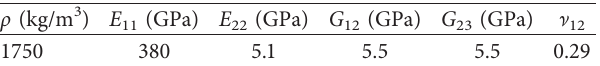
Table 1: Mechanical properties of the carbon fiber/epoxy com- posite